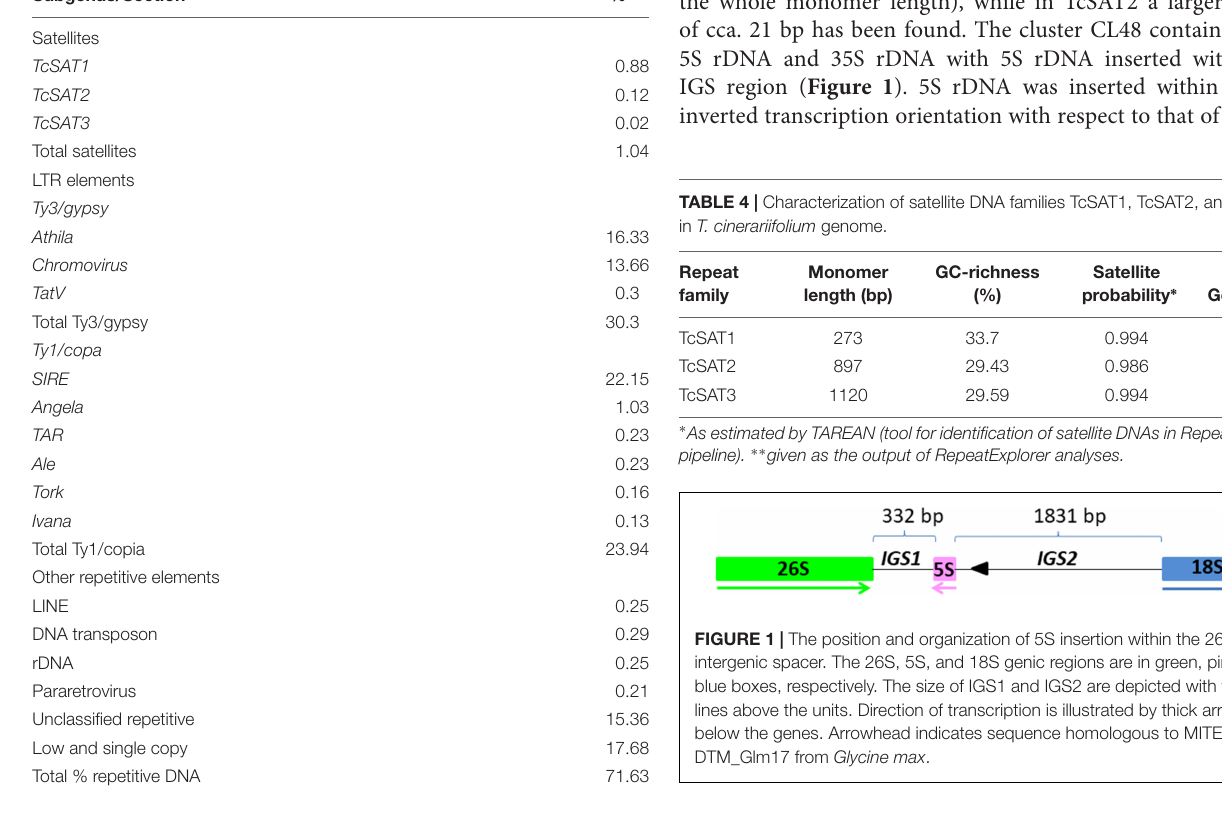
Frontiers in Plant Science |